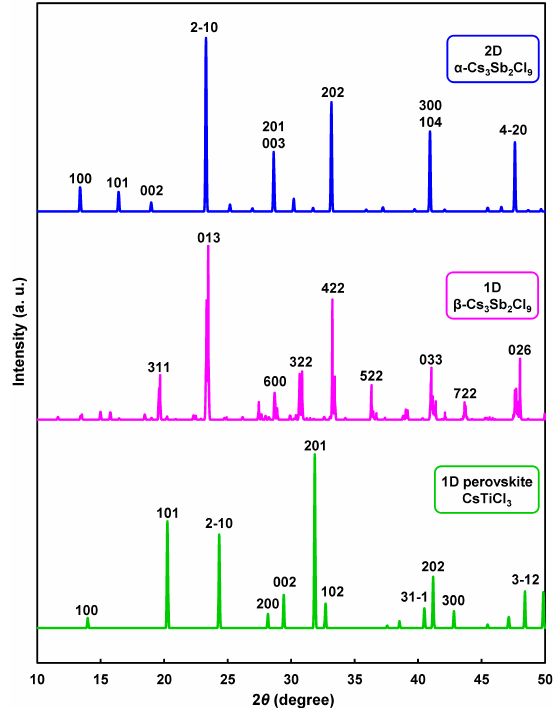
Figure 33: Structural models of (a) α -Cs 3 Sb 2 Cl 9 and (b) (CH 3 NH 3 ) 2 CuCl 4 with 2-dimensional perovskite structures. H atoms are omitted in (b).